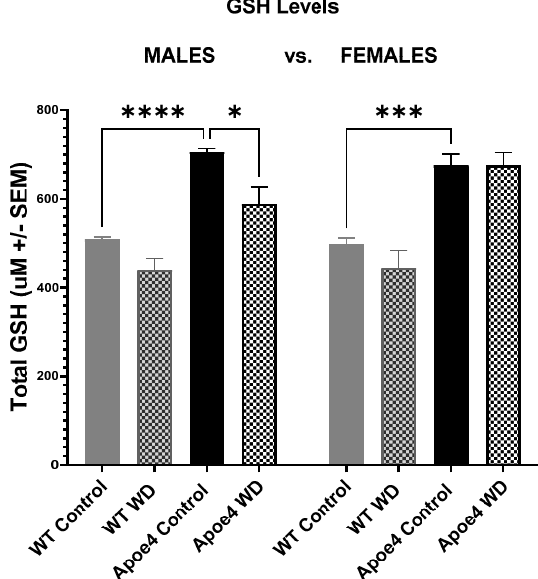
Figure 5. Liver glutathione levels . Baseline glutathione levels are higher in ApoE4 animals, relative to WT, and were significantly reduced only in male Western diet ApoE4 mice, ( p < 0.05) and not females, suggesting a possible protective effect on impaired liver function and oxidative stress in these animals. * p < 0.05, *** p < 0.001, **** p < 0.0001 .